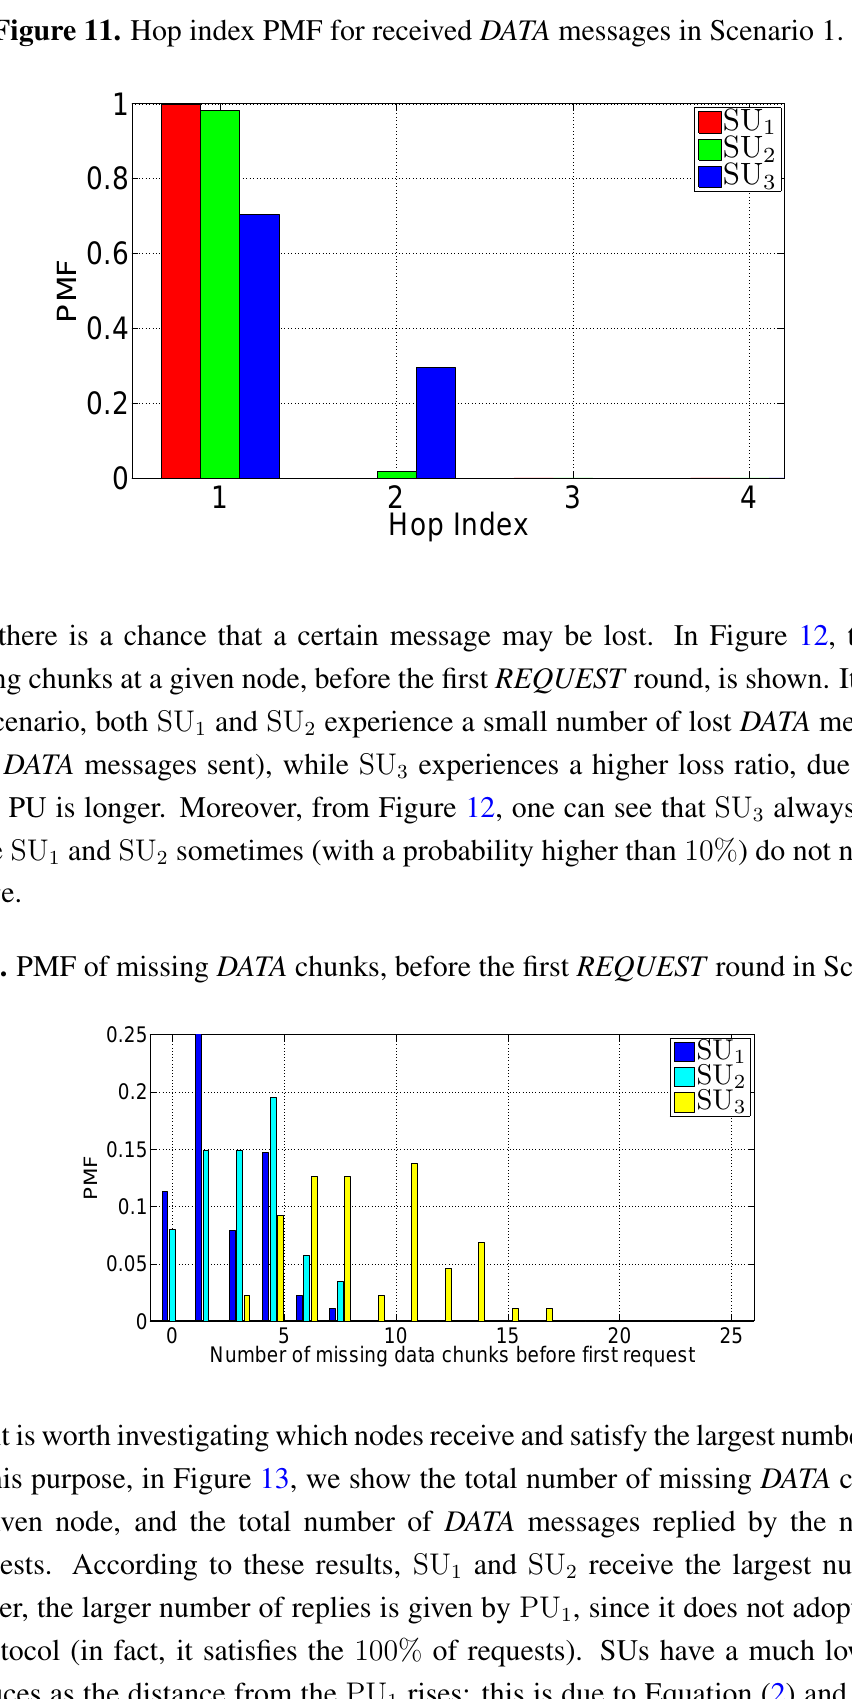
Figure 11. Hop index PMF for received DATA messages in Scenario 1.